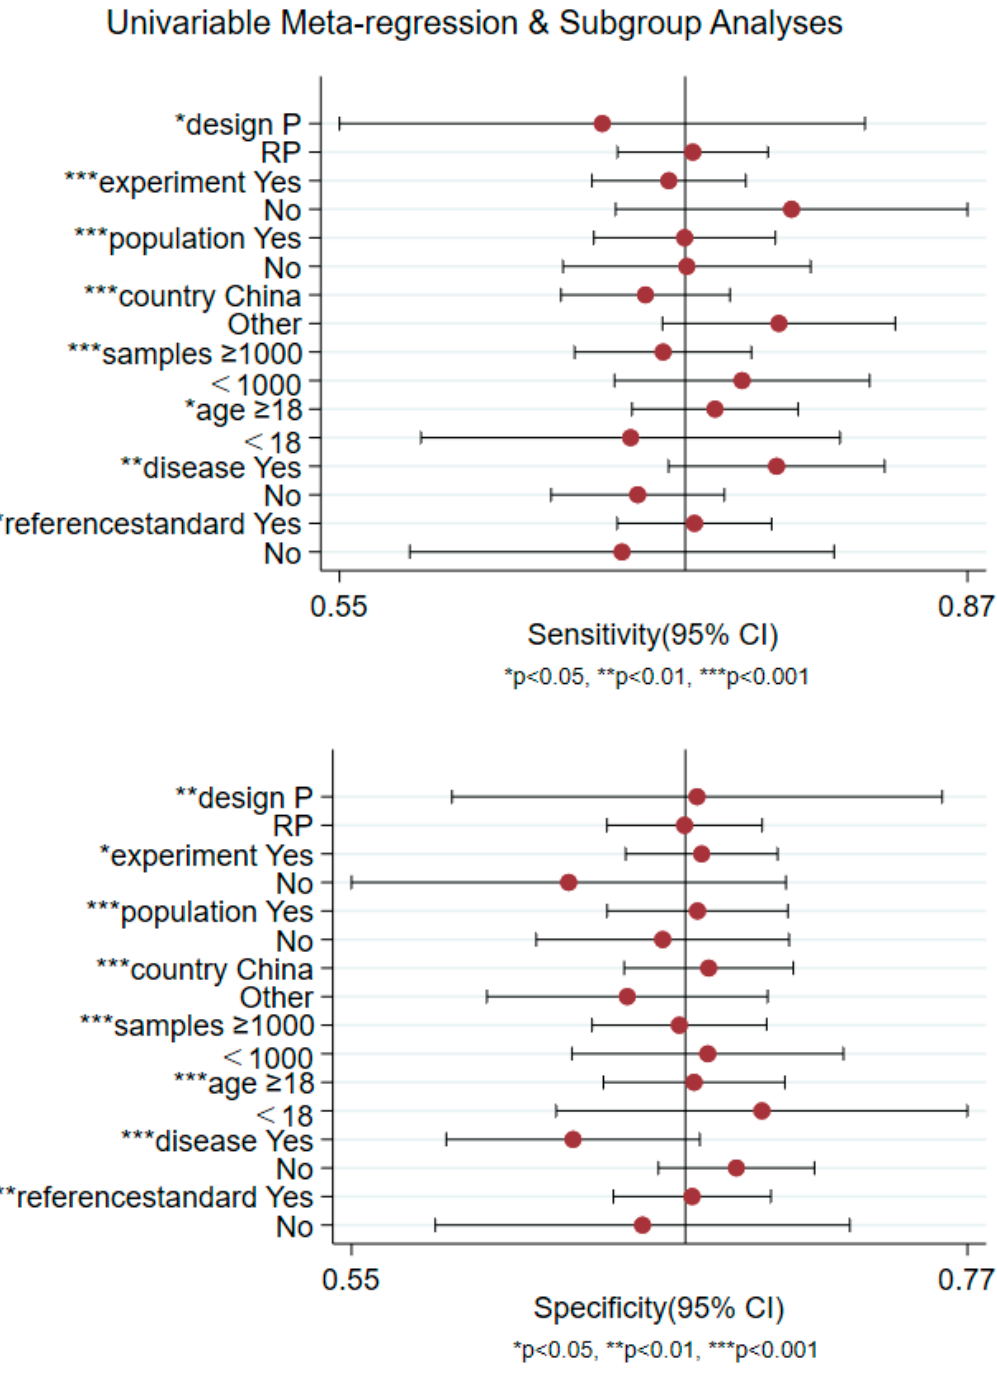
Figure 7. Univariable meta ‐ regression and subgroup analyses for different variables to discover sources of heterogeneity (RP, retrospective; P,